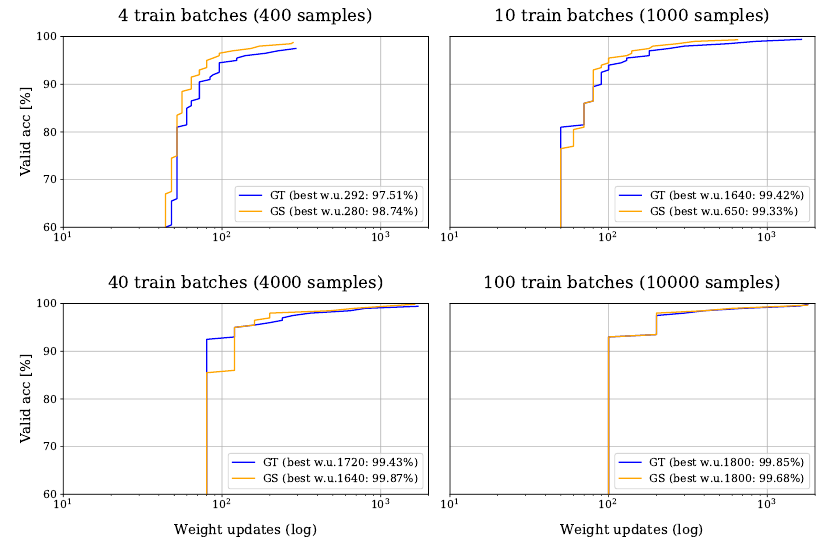
Figure 7. CNN performance milestone reached over number of weight updates—Synthetic data. Figure notation: Valid acc—Accuracy performance metric measured on the validation set. Best w.u.—Weight update after which the highest performance was